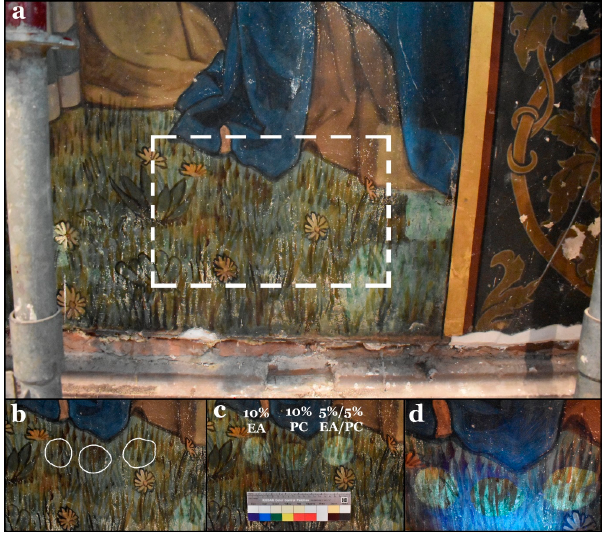
Figure 8. ( a ) General view of the selected area for the third-stage tests. ( b ) Selected areas before treatment. ( c ) The surface after treatment with the three hydrogel composites. Spots treated with the 10% EA and 5%/5% EA/PC hydrogel composites were overcleaned. ( d ) The same view under UV light showing the same observation regarding the overcleaning effect.